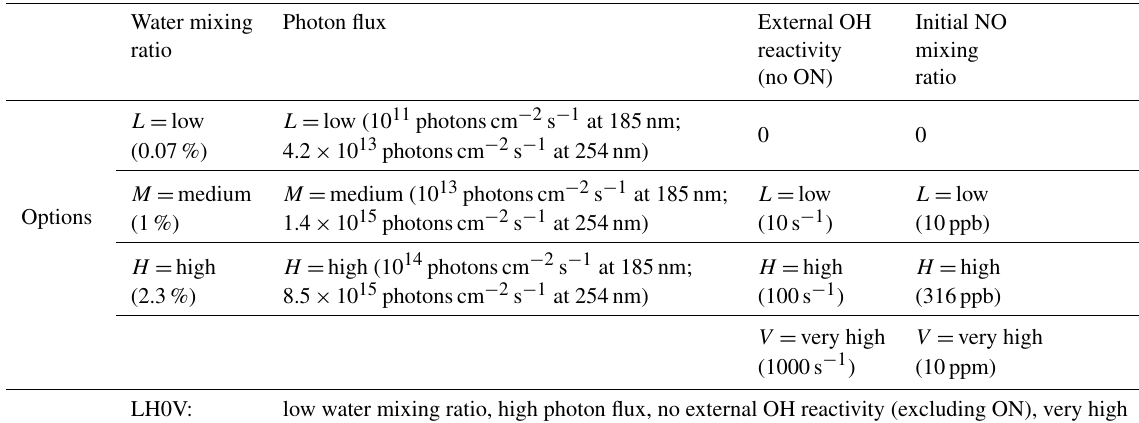
Table 2. Code of the labels of typical cases. A case label can be composed of four characters denoting the water mixing ratio, the photon flux, the external OH reactivity excluding N-containing species, and the initial NO mixing ratio. A case label can also be composed of two characters denoting the water mixing ratio and the photon flux.